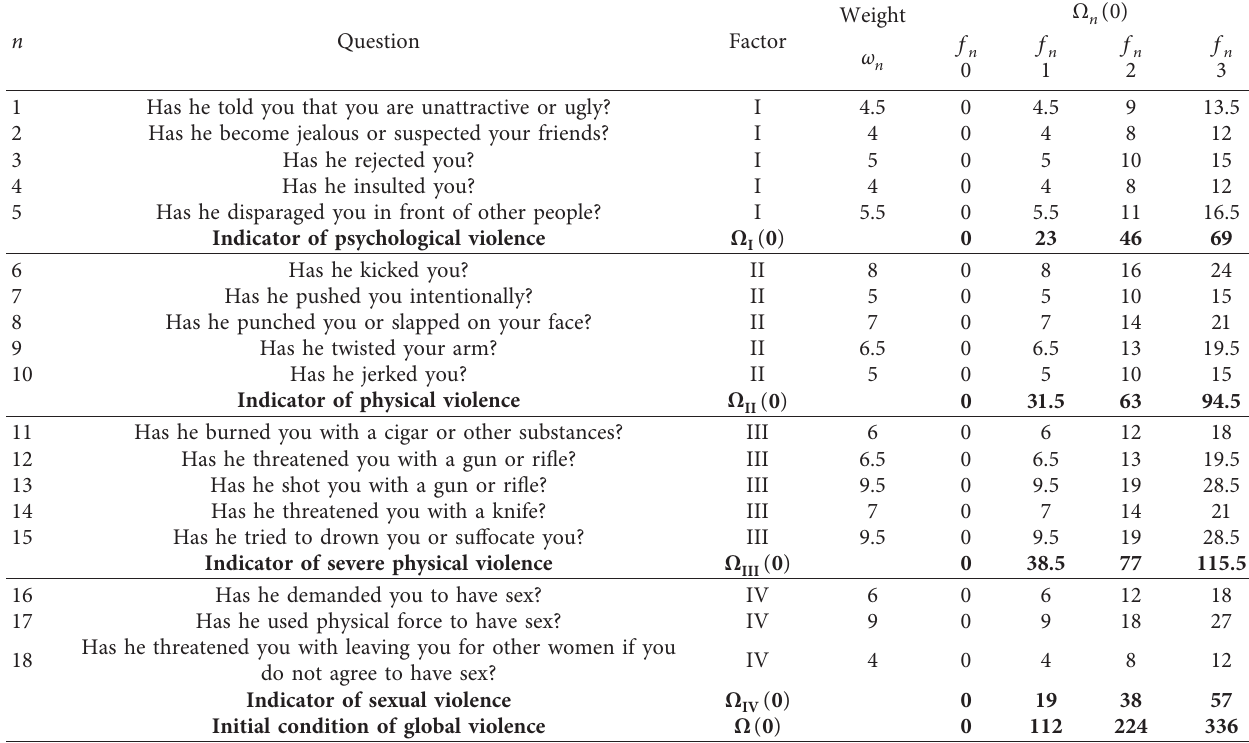
n , weight ω n , and